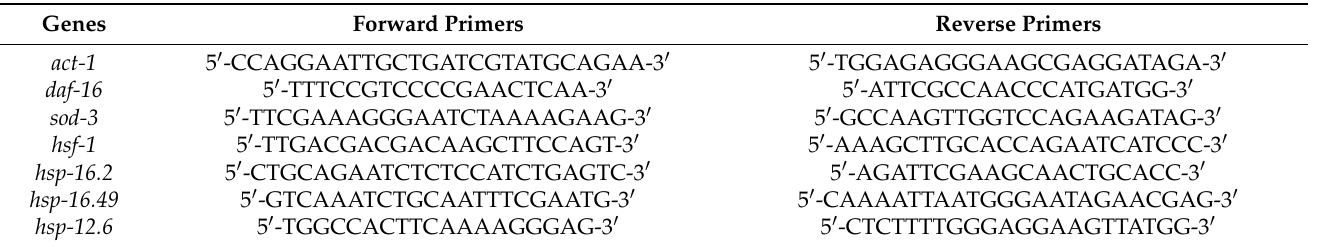
Table 1. Specific genes